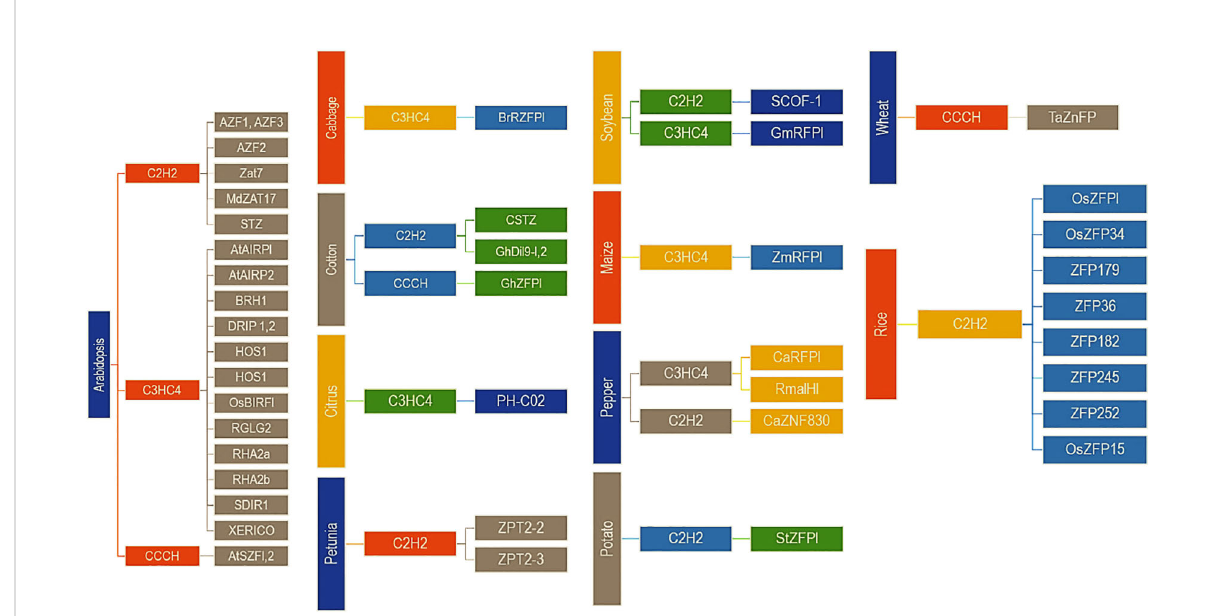
FIGURE 2 Some important Zinc Finger Proteins (ZNPs) involved in abiotic stress factors of the plants (1 st order of the hierarchy is the name of the crop/ plant, 2 nd order is the type of the protein and 3 rd order is the name of the ZNPs) (Source: Modi fi ed after Noman et al. (2019) with the permission from the Elsevier Rights Links (https://s100.copyright.com/), Licence No.: 5371200779212, Dated 17 th August